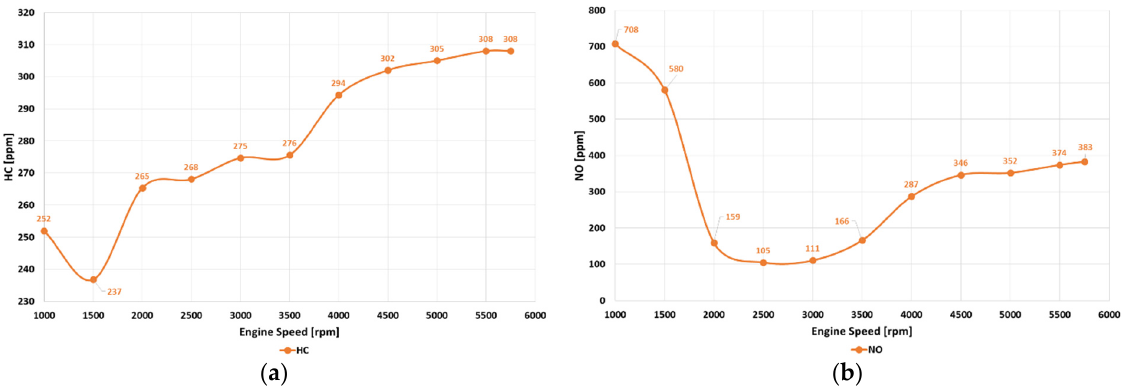
Figure 14. ( a ) HC and ( b ) NO predicted emissions.